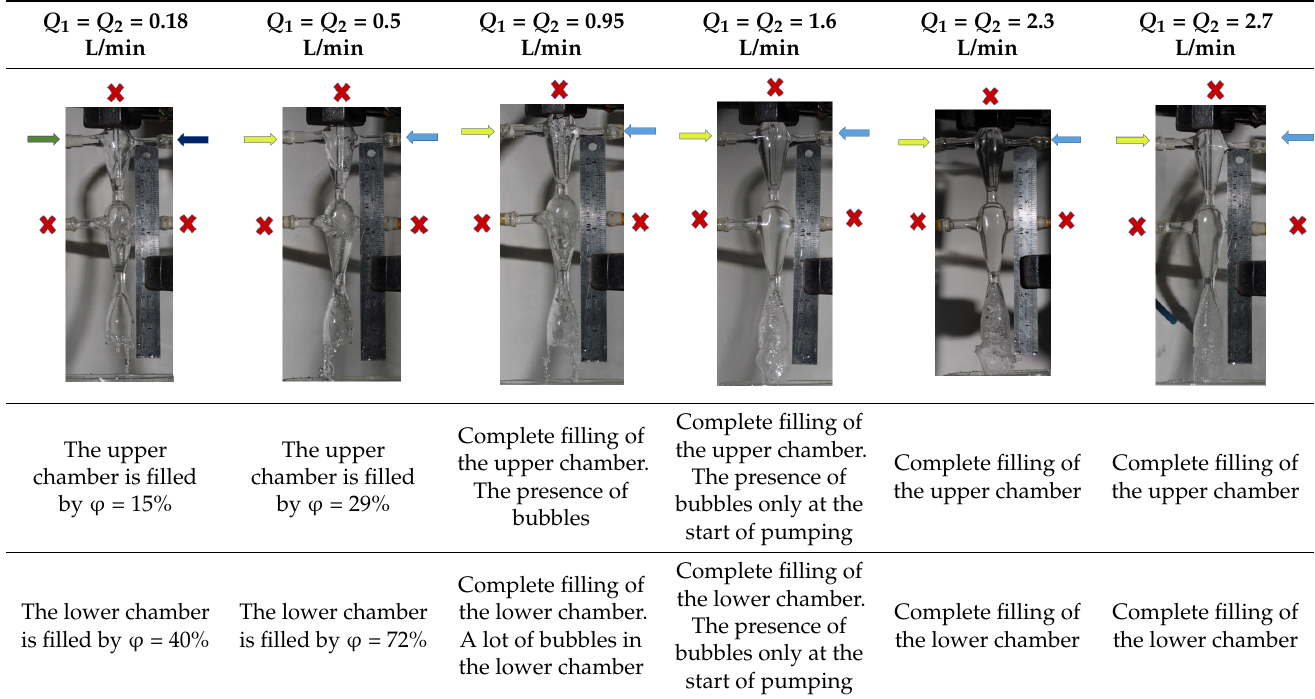
The upper chamber is filled by φ = 15%